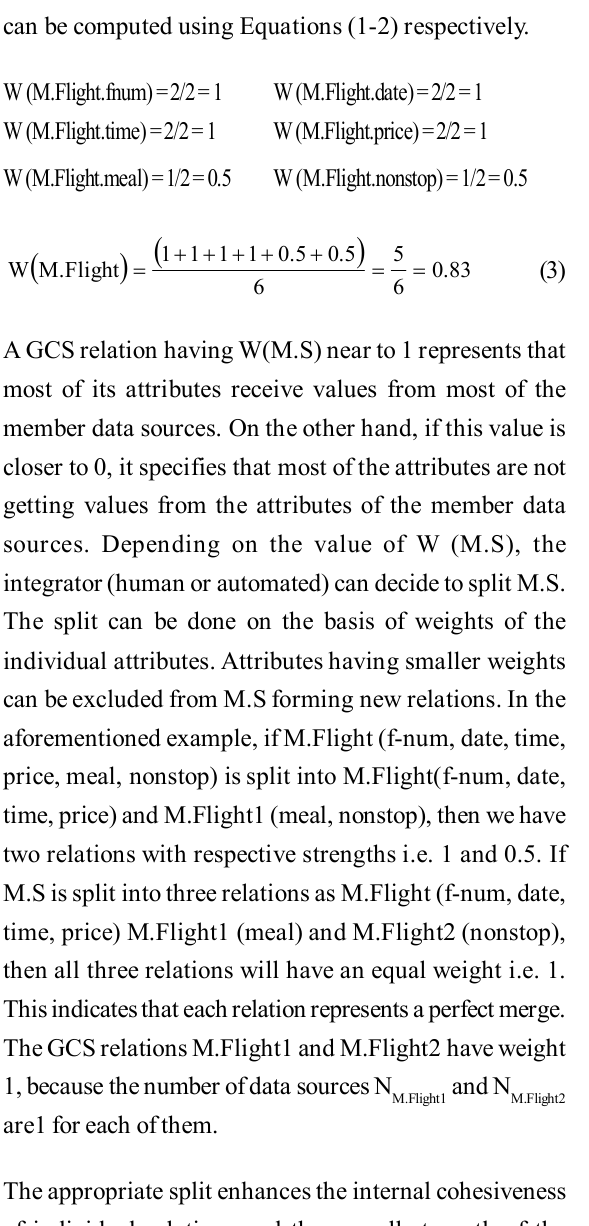
FIG. 2. MEMBER RELATIONS WITH MATCHING